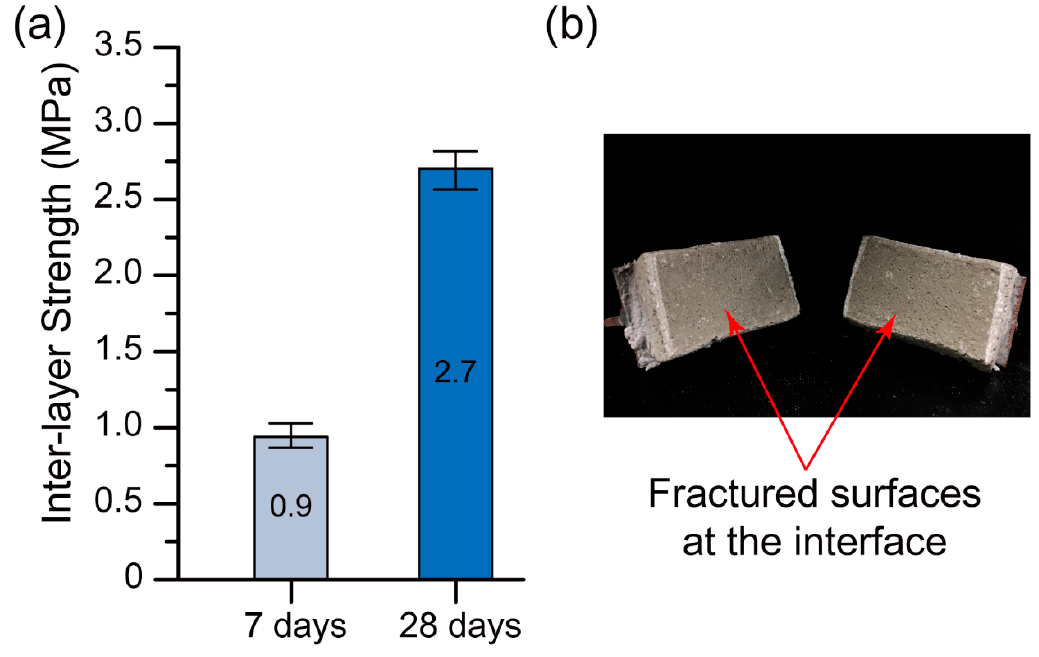
Figure 13. ( a ) Interlayer bond strength of Na-N-2.5 (the optimum 3D printable mixture). ( b ) Failure mode of a tested specimen.